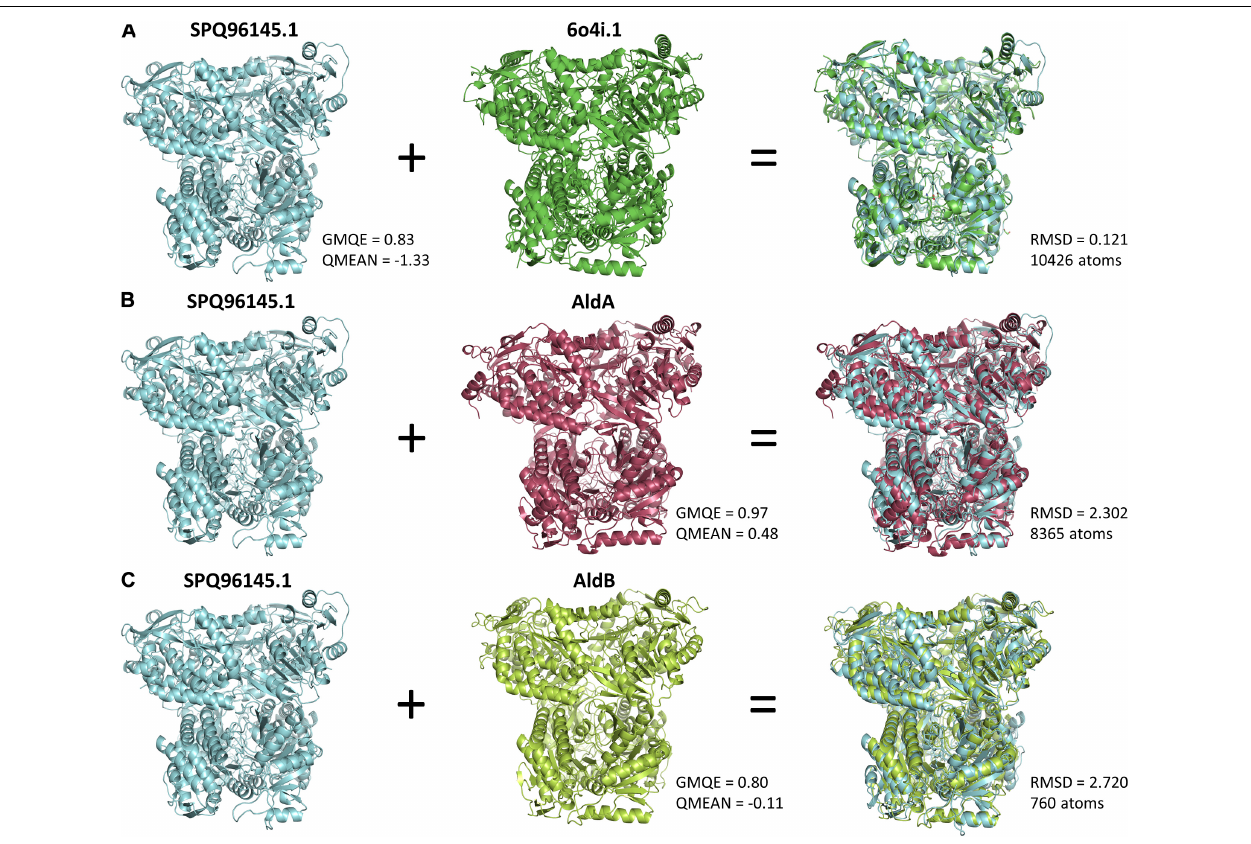
FIGURE 5 | Predicted 3D structure of aldehyde dehydrogenases. (A) The aldehyde dehydrogenase from P. brassicae (SPQ96145.1) was predicted using Alpha-aminoadipic semialdehyde dehydrogenase (STML ID:6o4i.1.A – second structure from left to right) using Swiss-model. The structural alignment of the two structures can be seen on the third column. (B,C) Models for aldehyde dehydrogenases A and B (AldA and AldB -second column) from P. syringae which are involved in IAA synthesis, were aligned with the P. brassicae model, to produce the structural alignments seen on column 3. RMSD, root mean square deviation of all aligned atoms between the two structures, where a value of 0 is a perfect alignment. The number of aligned atoms is also reported for the three structural alignments. A Global Model Quality Estimation (GMQE) score closer to 1 represents more accuracy in the models, and a QMEAN value above –4 is indicative of good quality of the structure